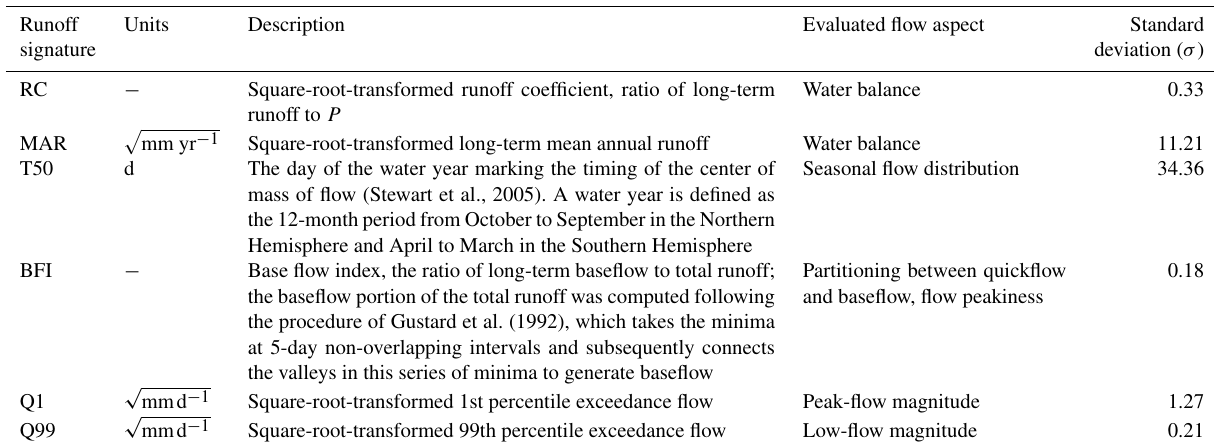
Table 3. The long-term runoff behavioral signatures considered for evaluating the model performance. The signatures were computed, for each catchment, from the entire record of simultaneous observed and simulated runoff. The σ values represent the spatial variability in the runoff signatures across the